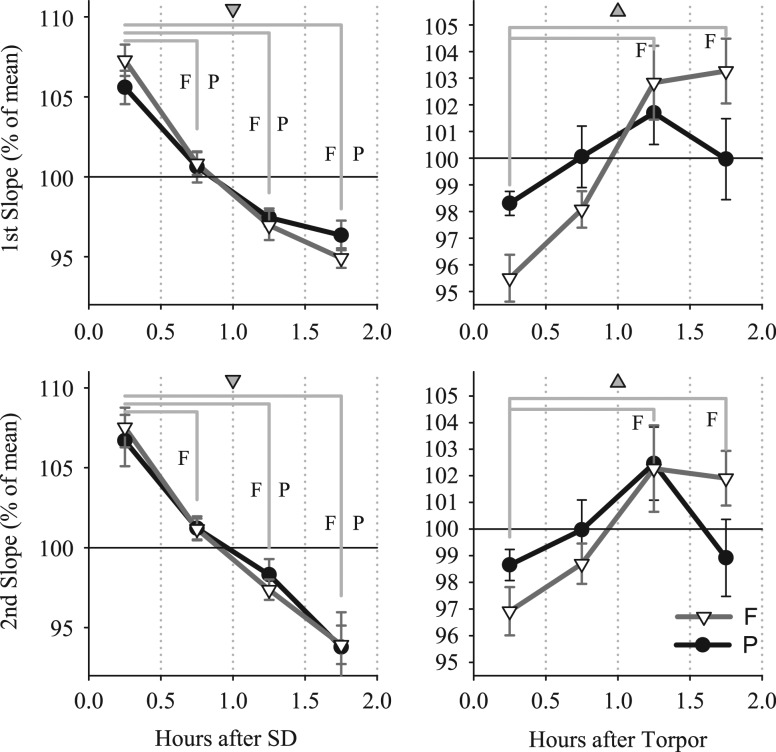
Time course of EEG slow-wave slopes in NREM sleep during the first 2 h after SD (left panels) and after TOR (right panels). Mean values (n = 6) ± SEM are shown for 30-min intervals as % of corresponding mean values over the entire 2-h interval. The change in slopes from the first 30-min interval is assessed by post hoc Dunn-Sidak multiple comparison test after significance in one-way ANOVA (gray triangles: P < 0.05, the orientation of triangles denotes the directionality of change from the first 30-min interval). For each comparison shown with straight gray lines, the letter F or P corresponds to a significant difference found for the frontal and parietal derivation, respectively.